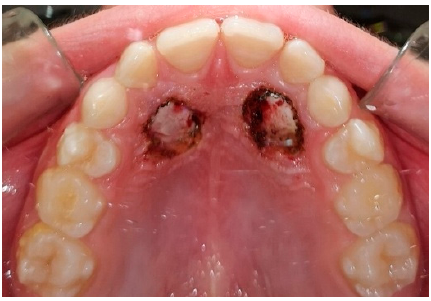
Figure 4. Laser surgery.